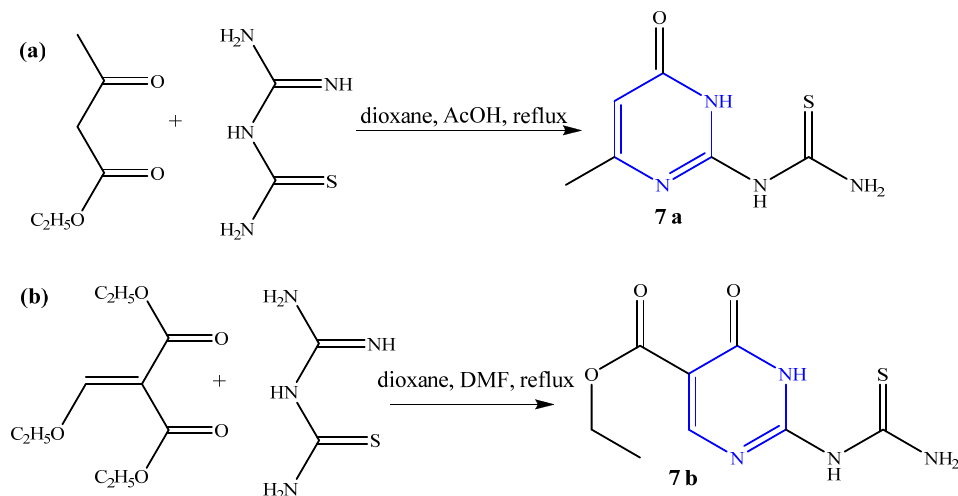
Figure 3. Synthesis of 4-oxopyrimidin-2-ylthioureas from amidinothiourea and ethyl acetoacetate ( a ) or diethyl ethoxymethylenemalonate ( b ).